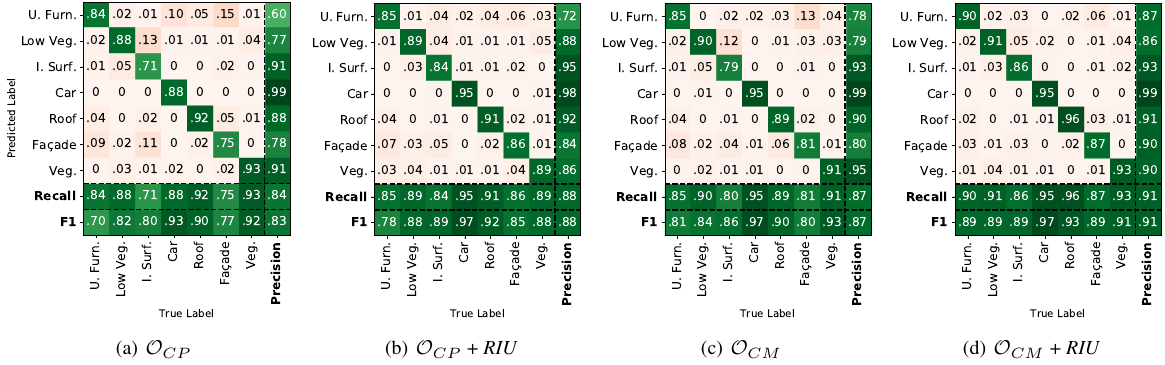
Figure 3. Achieved labeling accuracies of crowd oracles both with and without RIU , representing the vicinity of a point either as point cloud ( a and b ) or as 3D mesh ( c and d ).